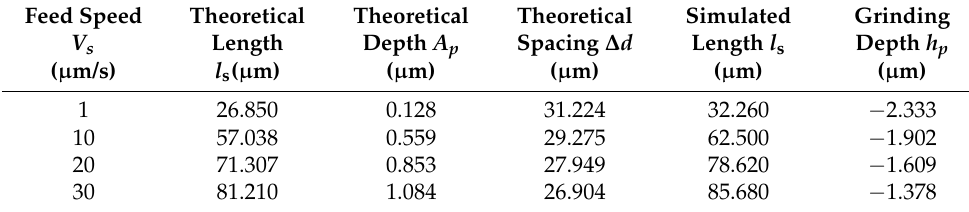
Table 5. Micro-pit dimension comparison of Group